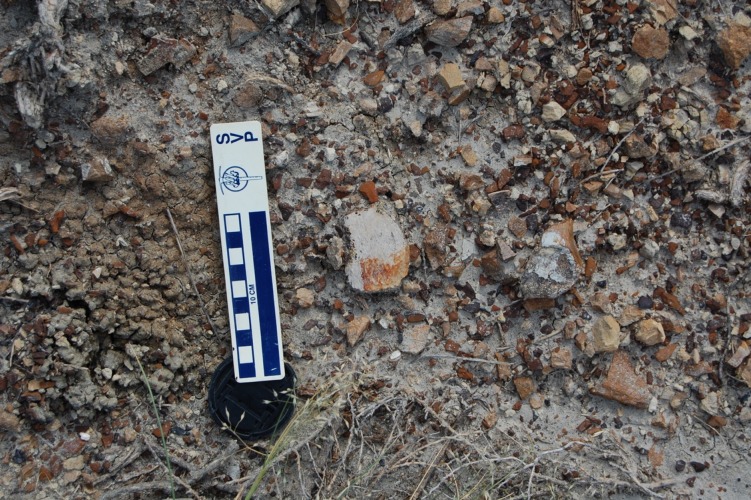
Surface eroded bone fragments from BB180 as they were found.